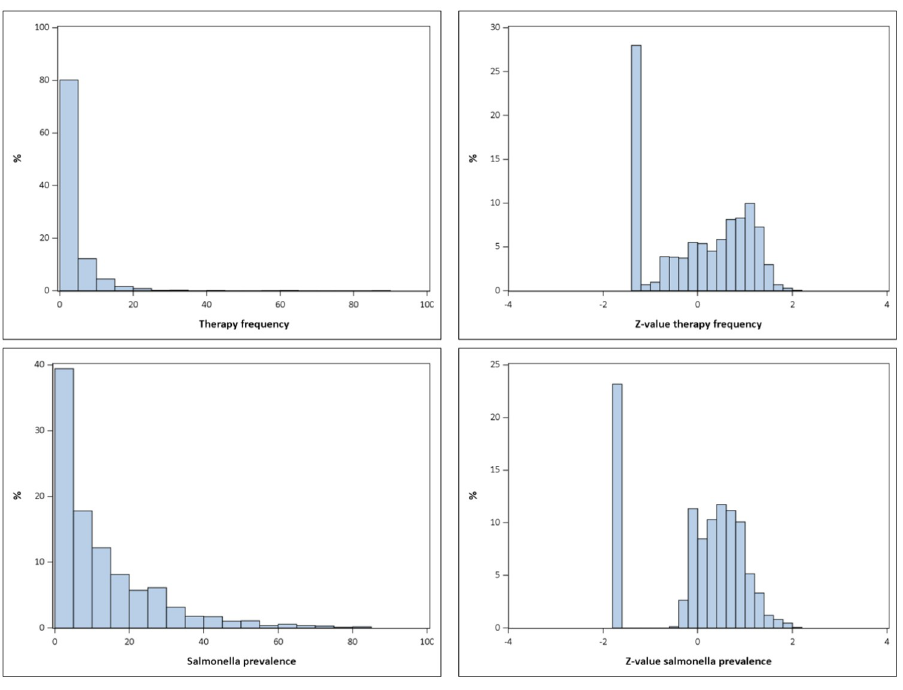
Fig 2. Distribution of therapy frequency and Salmonella prevalence and their